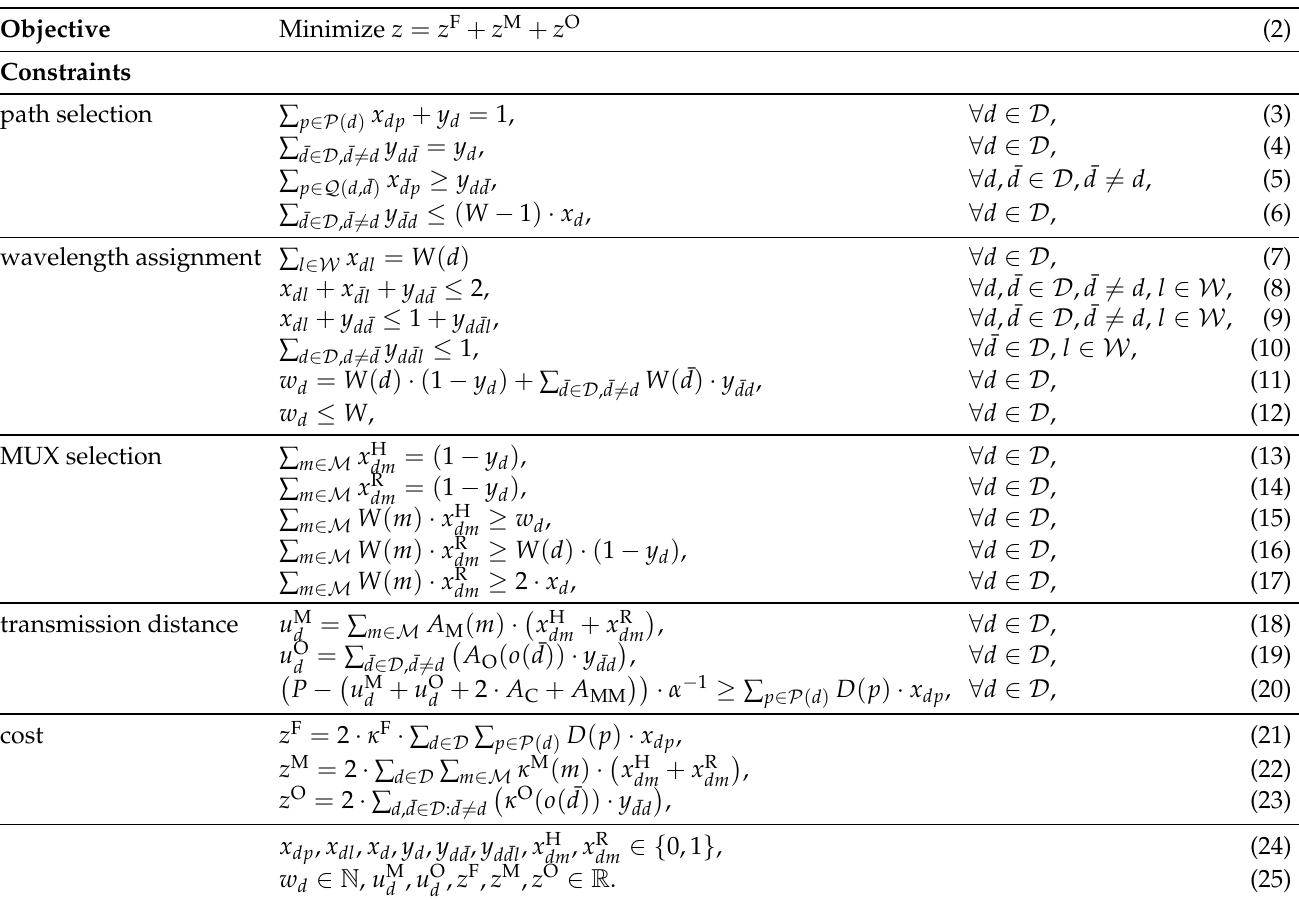
Table 1. MILP model of the network planning